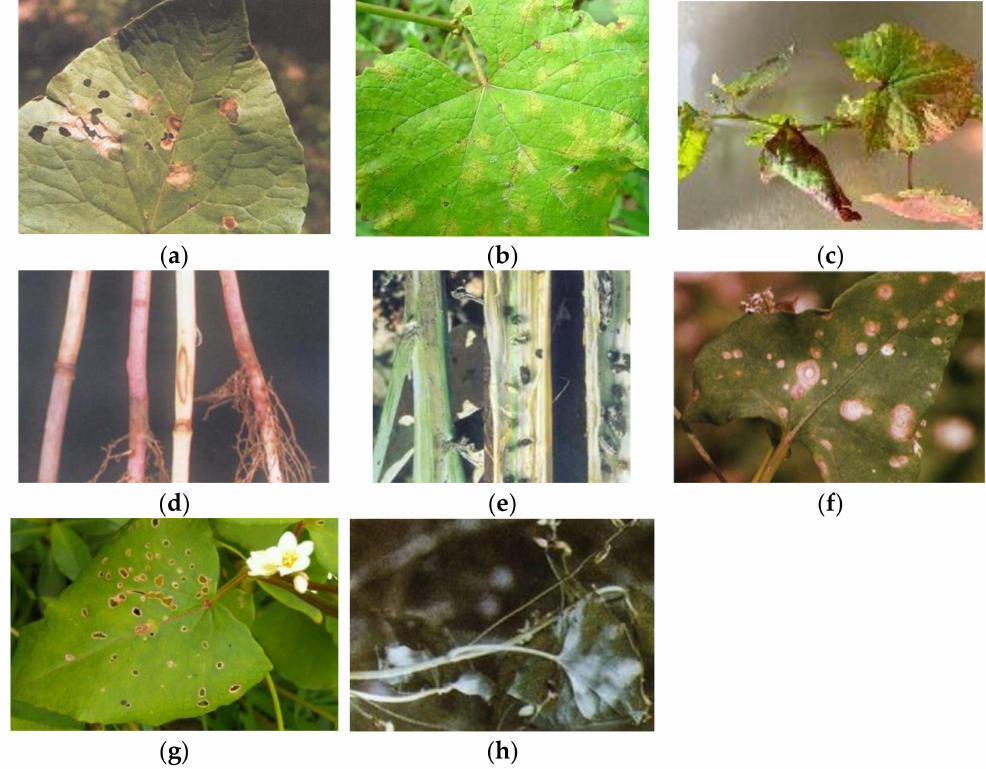
Figure 2. A sample image of each detected class. ( a ) Spot blight; ( b ) Downy mildew; ( c ) Virus disease; ( d ) Seedling blight; ( e ) Sclerotinia; ( f ) Ring spot; ( g ) Brown spot; ( h ) White